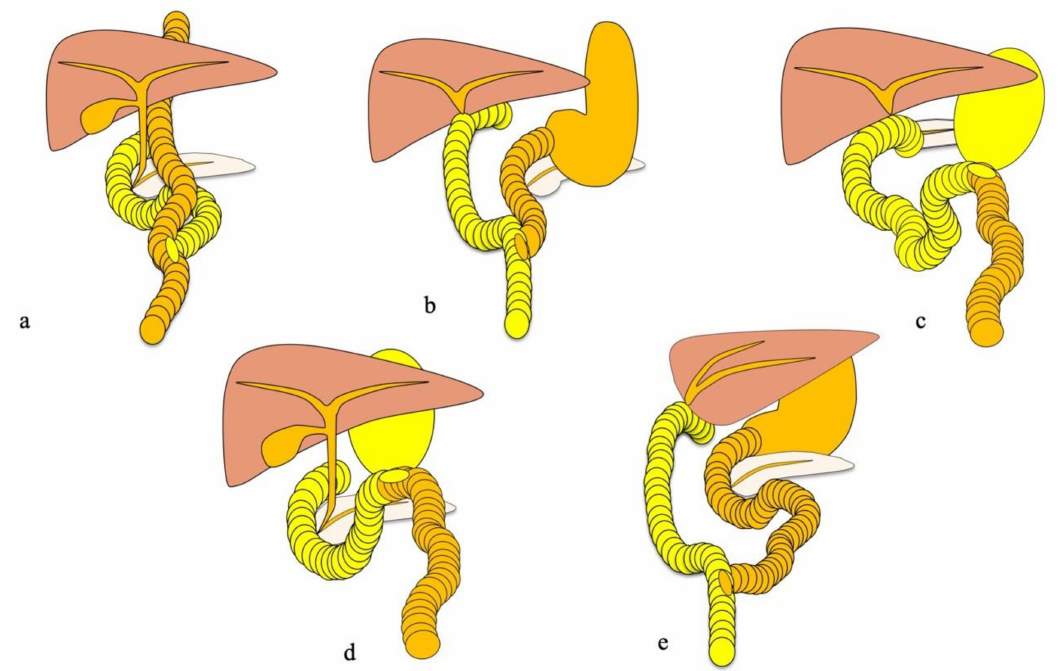
Figure 1. Operative procedures: ( a ) Roux-en-Y hepaticojejunostomy; ( b ) status post-living donor liver transplantation; ( c ) Roux-en-Y gastrectomy; ( d ) Billroth-II remnant resection; ( e ) pancreaticoduodenectomy.